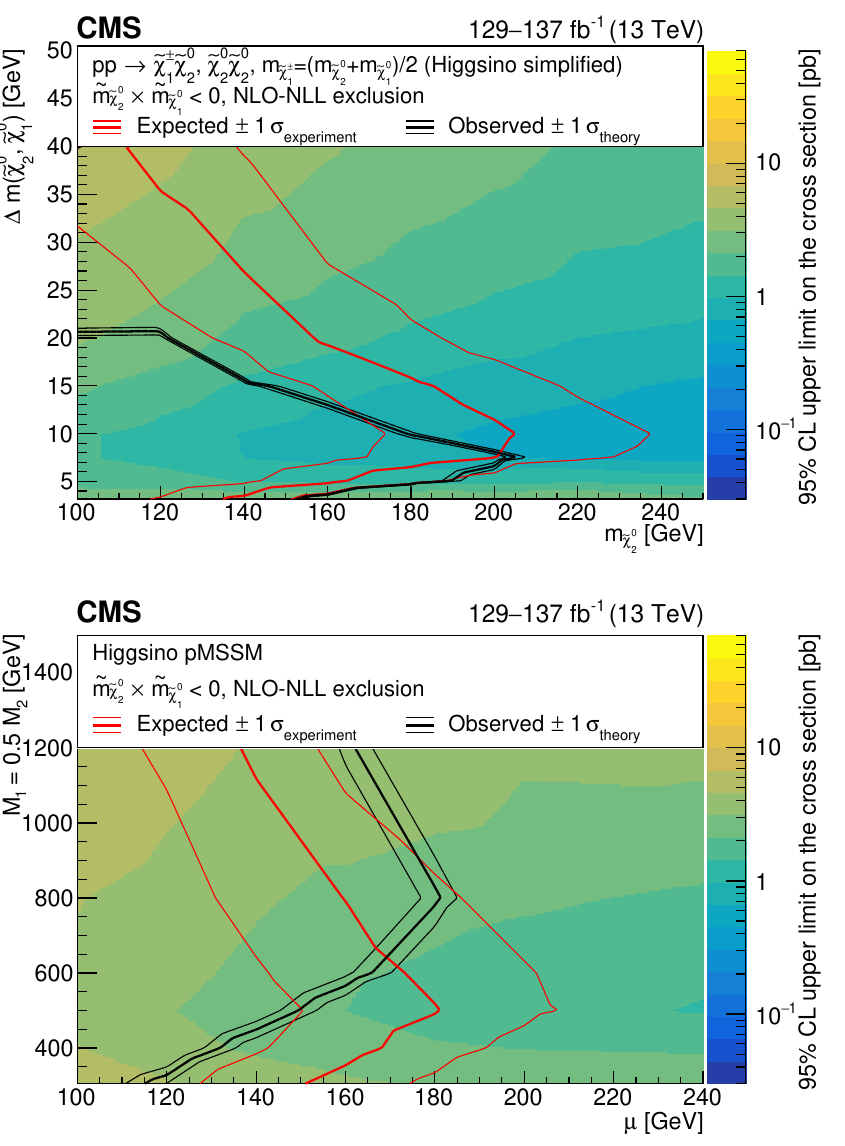
Figure 9 . The observed 95% CL exclusion contours (black curves) assuming the NLO+NLL cross sections, with the variations (thin lines) corresponding to the uncertainty in the cross section for the simplified (upper) and the pMSSM (lower) higgsino models. The simplified model includes both neutralino pair and neutralino-chargino production modes, while the pMSSM one includes all possible production modes. The red curves present the 95% CL expected limits with the band (thin lines) covering 68% of the limits in the absence of signal. The results are reported for the m m < 0 M ( ‘‘ ) spectrum reweighting scenario. The range of luminosities of the analysis regions 0 0 e e e c e c 2 1 included in the fit is indicated on the